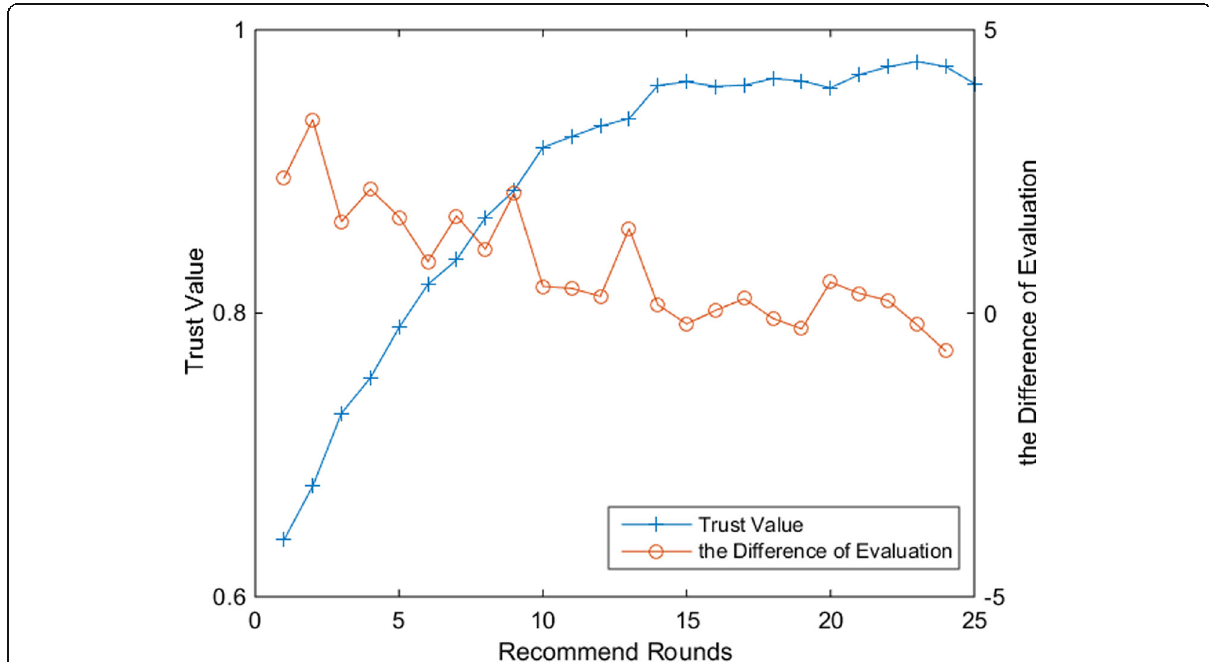
Fig. 9 Correlation graph of evaluation and trust (with LMS and η = 0.2)